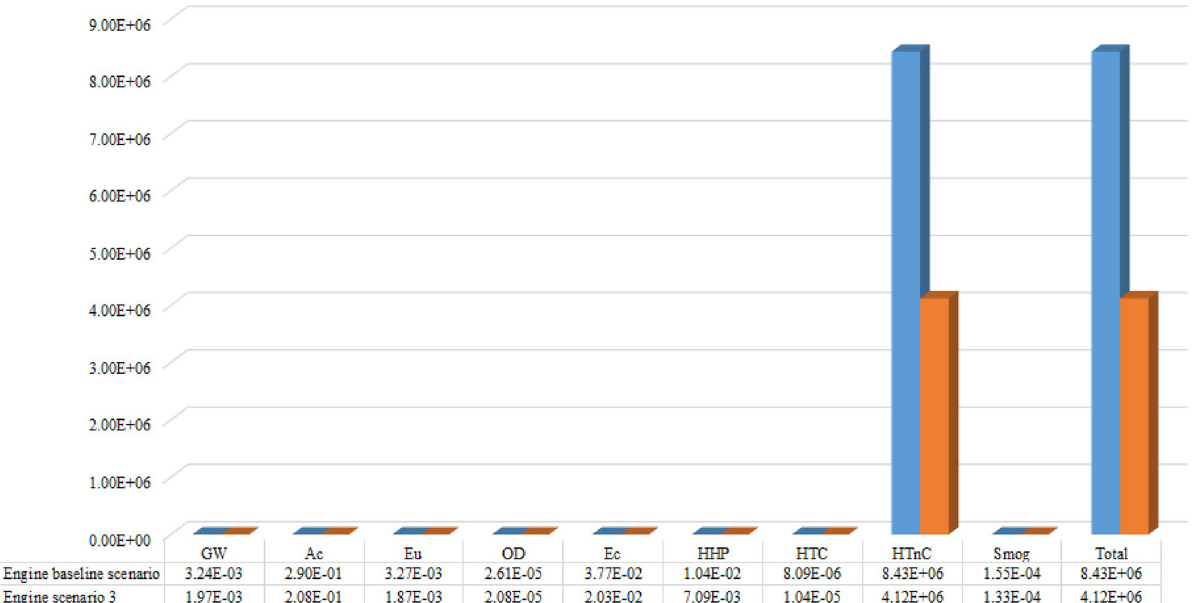
Figure 6. Comparison of the relative contributions by the category indicators, of coil former and coil. The Ec and HTnC category for the coil is highlighted, with its impact percentage being approximately ten times greater than the